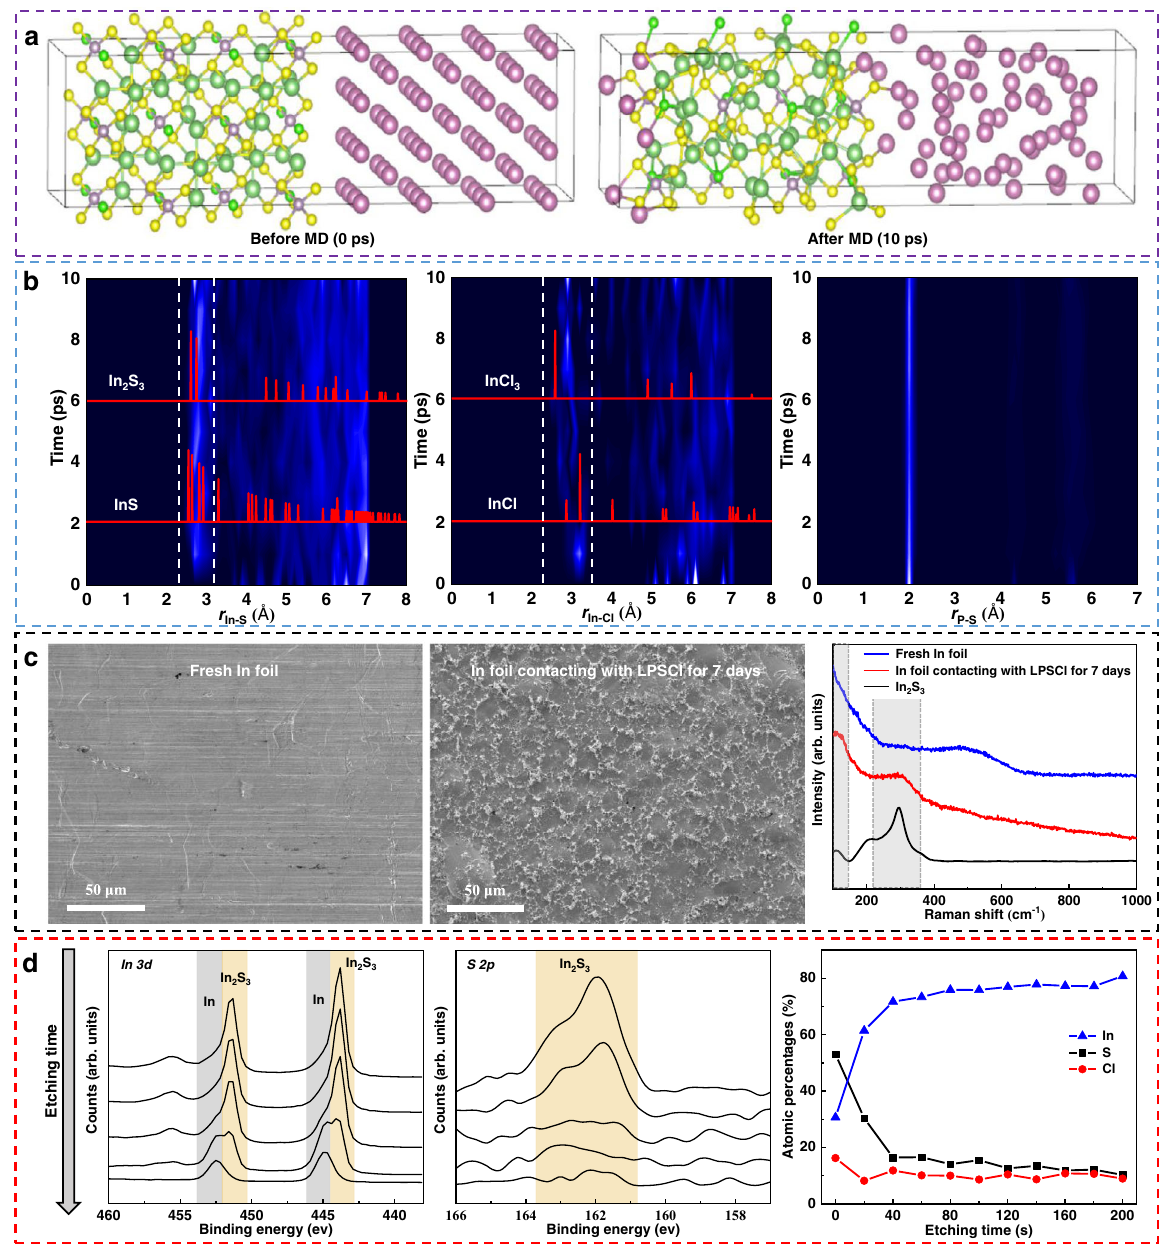
Fig. 5 AIMD calculations and Raman and XPS analysis of the LPSCl-In interface. a LPSCl-In interface models before MD (0 ps) and after MD (10 ps). b RDF evolutions of In-S, In-Cl, and P-S for the LPSCl-In interface during the simulation and RDFs of In-S and In-Cl for reference materials. c SEM images